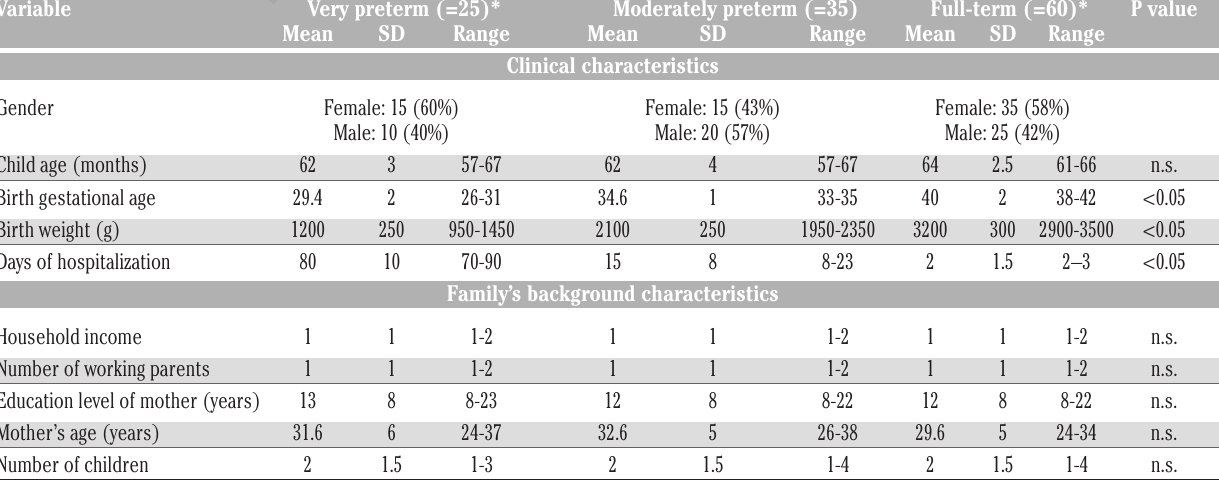
Table 1. Prenatal and family characteristics of the sample by term and preterm birth. Variable Very preterm